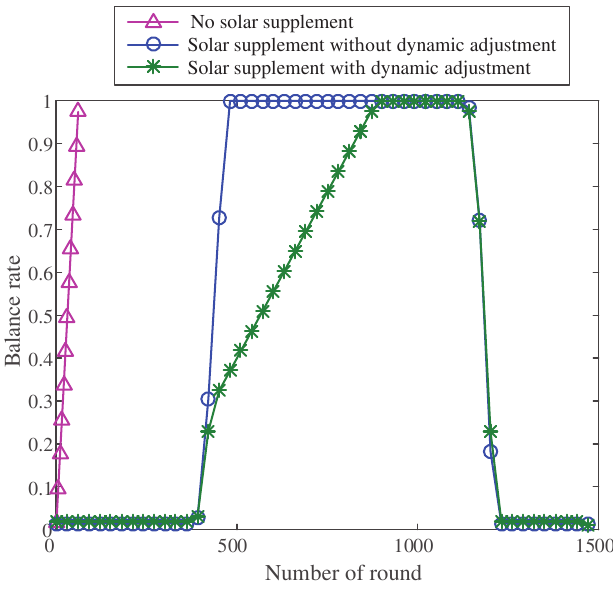
Figure 10. The comparison of